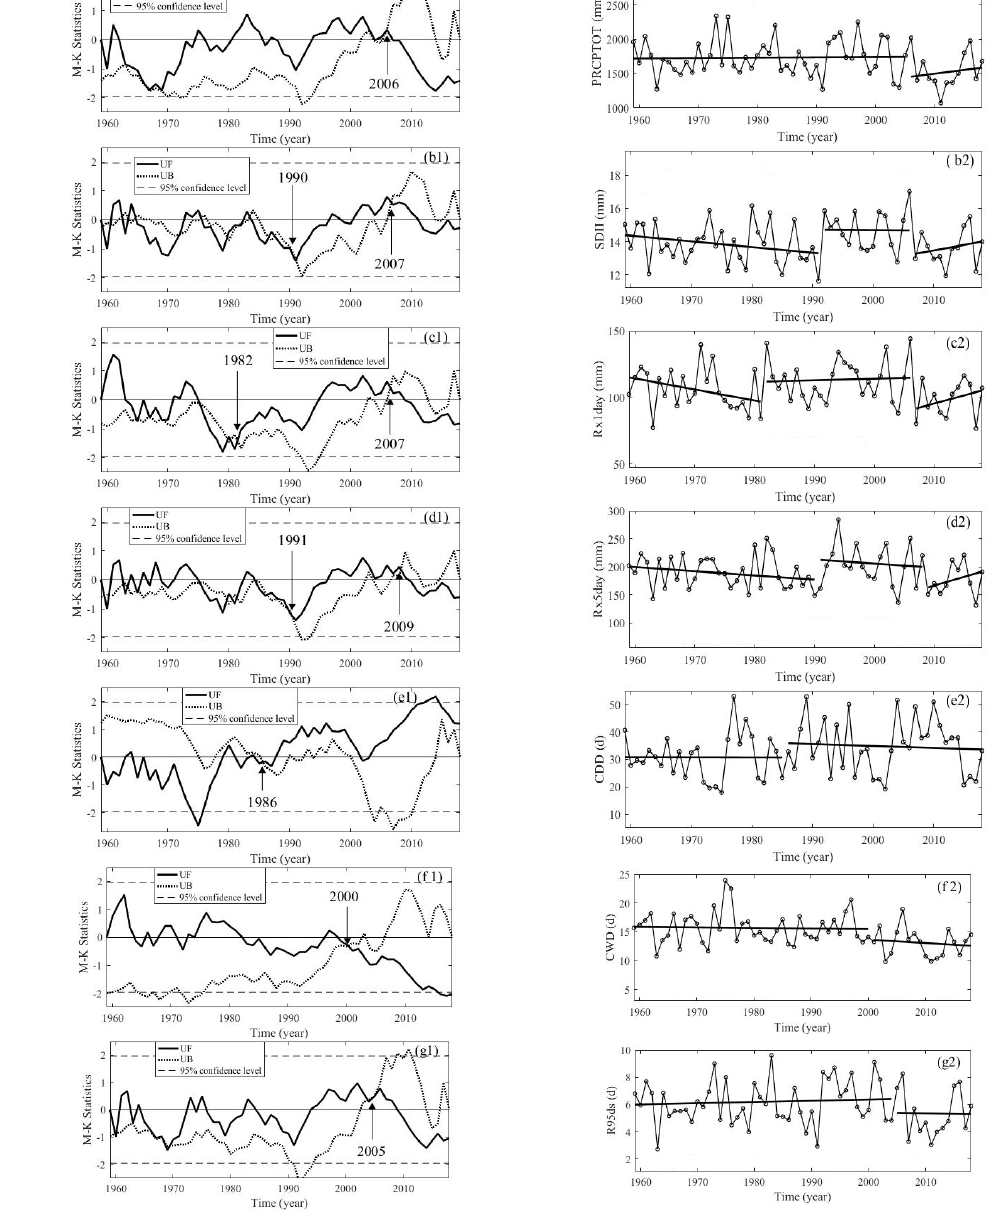
Figure 3. Mann–Kendall test and linear trends of PRCPTOT ( a1,a2 ), SDII ( b1,b2 ), Rx1day ( c1,c2 ), Rx5day ( d1,d2 ), CDD ( e1,e2 ), CWD ( f1,f2 ), and R95ds ( g1,g2 ). UF is forward data sequence Mann − Kendall statistics, and UB is reverse data sequence Mann − Kendall statistics.